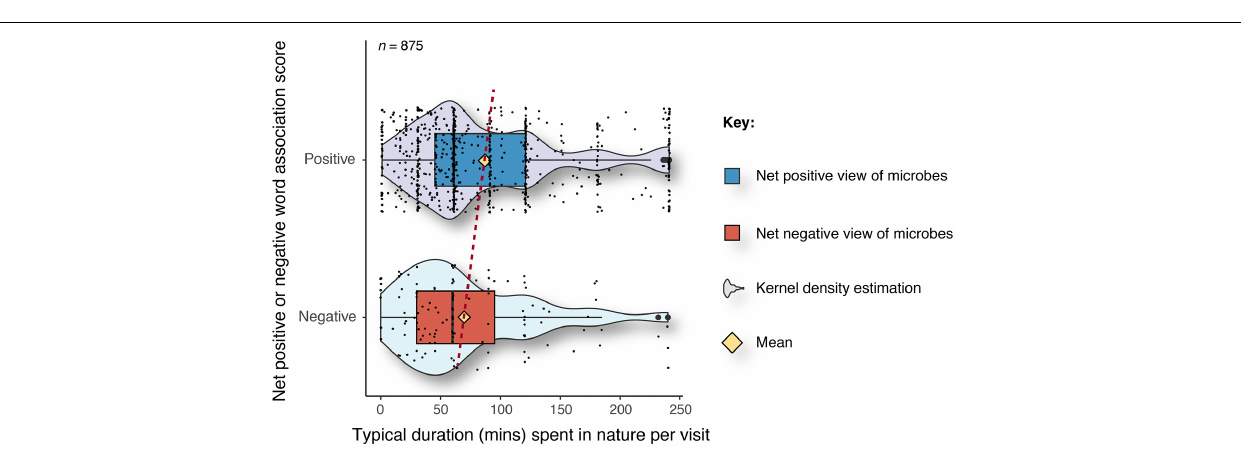
FIGURE 1 | Distribution of respondents, whereby panel (A) shows the global distribution, and panel (B) shows England, United Kingdom—the geographical source of the majority of responses ( n = 993).